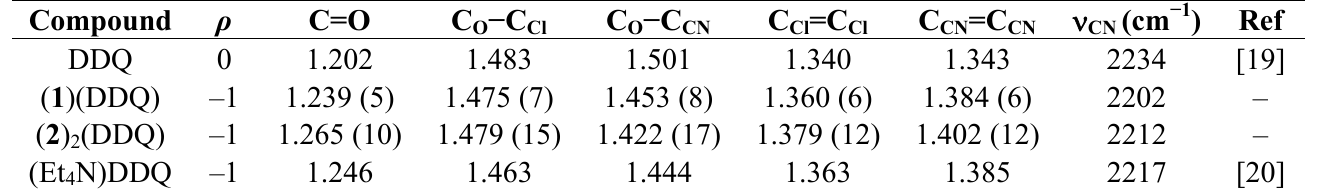
Table 2. Characteristic intramolecular bond lengths (in Å) in DDQ in various salts (averaged values). The formal charge and wave number of nitrile stretching absorption in IR spectra, for each molecule, are given as ρ  and v